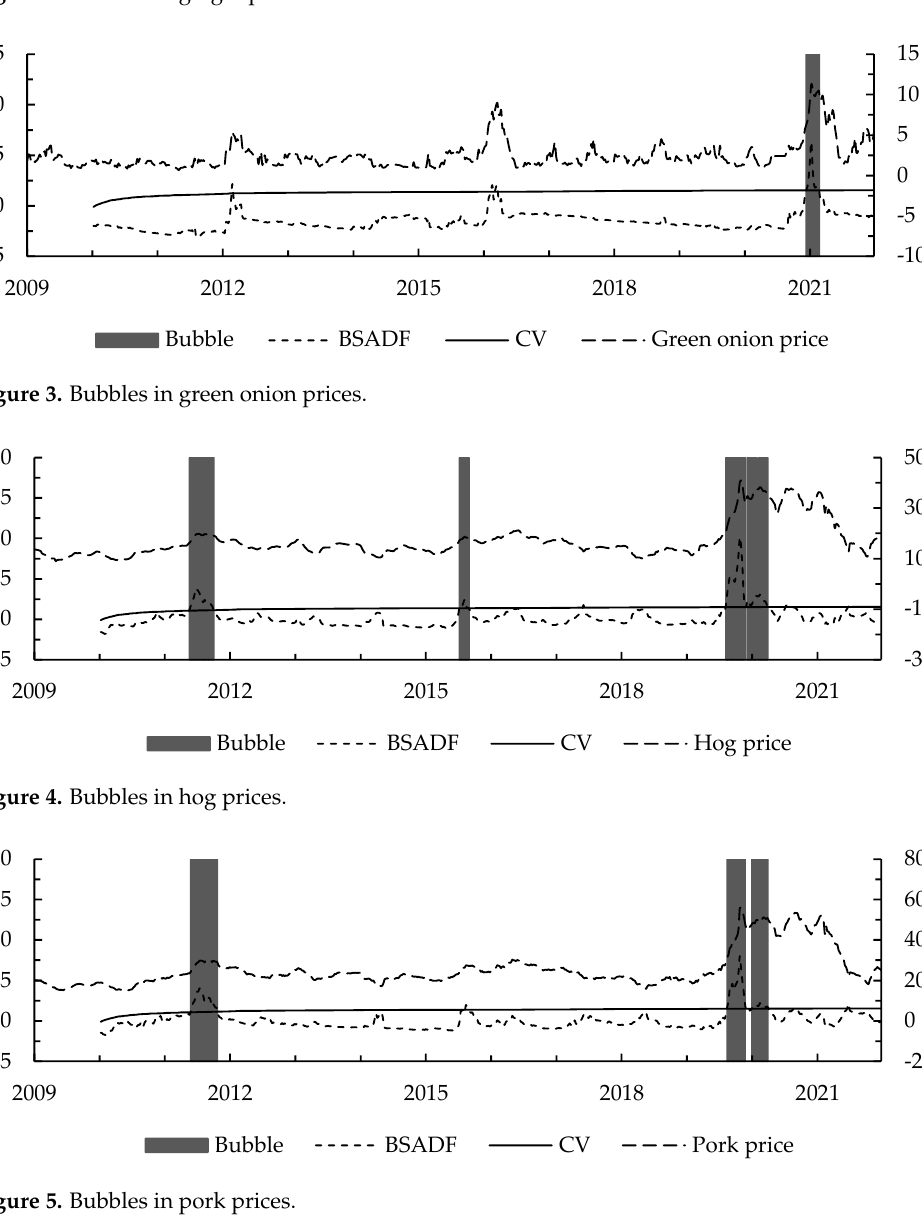
Figure 2. Bubbles in ginger prices.